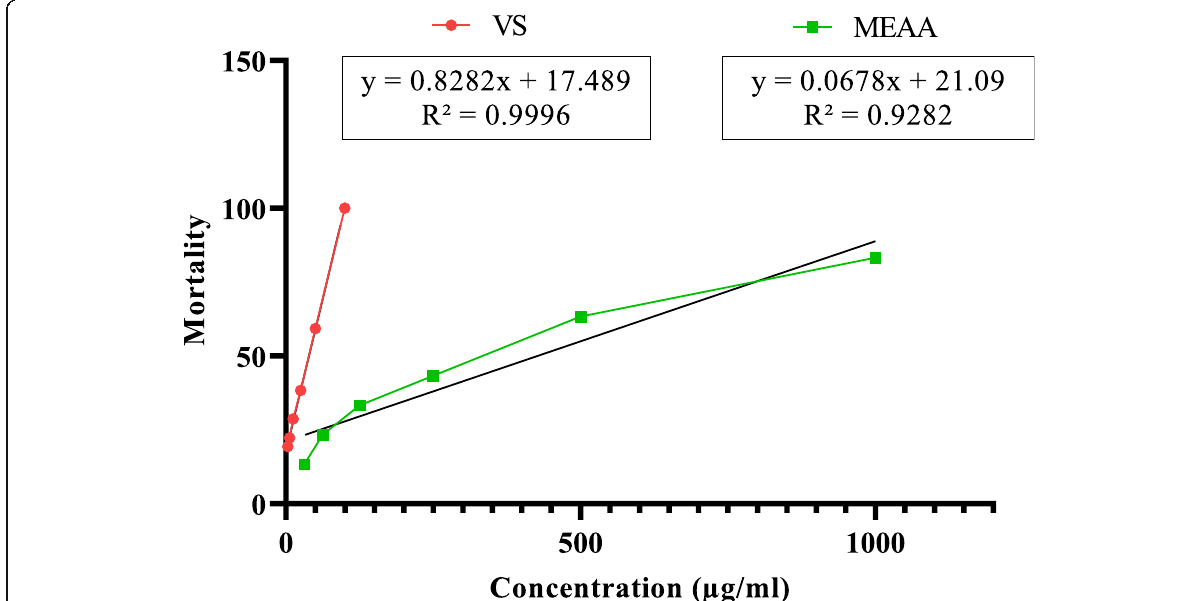
Fig. 1 Cytotoxicity of Methanol leaves extract of A . auriculiformis (MEAA) and Vincristine sulfate (VS) in brine shrimp lethality